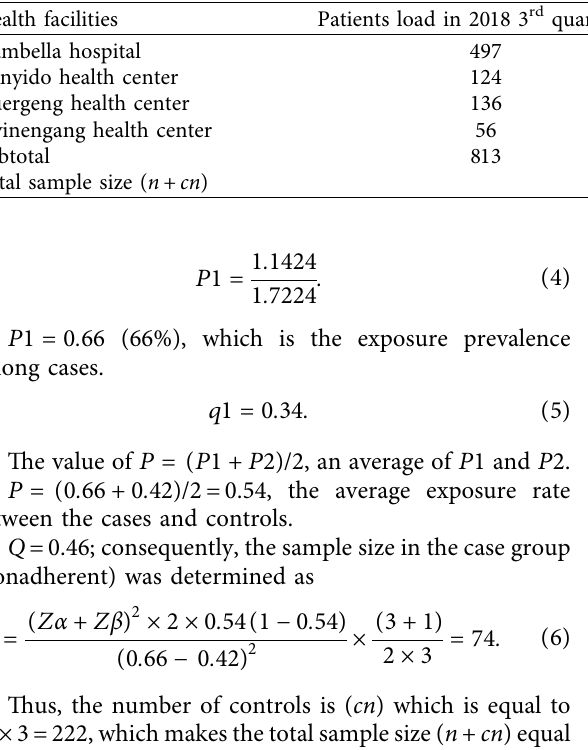
Table 1: Proportionate sample size allocation to four health facilities in the Gambella